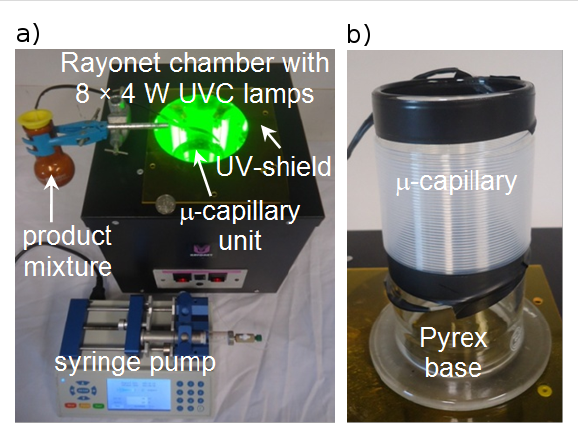
Figure 2: Microcapillary reactor. (a) Setup with inserted μ -capillary unit. A 10 AU-cent coin is shown for comparison. (b) μ -Capillary